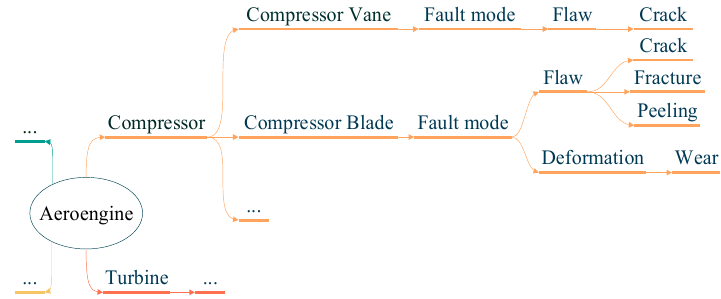
Figure 3. Semantic diagraph of fault mode.